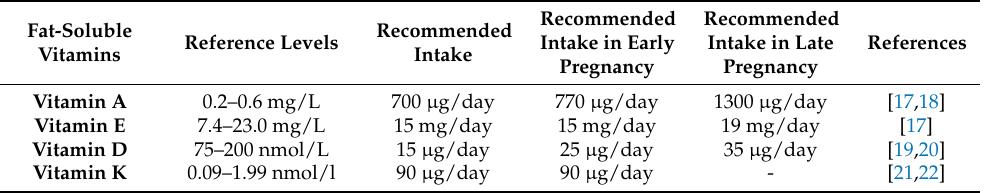
Table 1. Normal reference levels and recommended intake of fat-soluble vitamins A, E, D, and K in different physiological